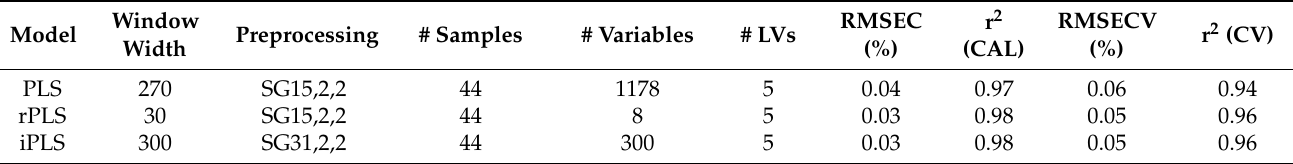
Figure 1. Map of Greece indicating the sample localities. Figure 7. Response surface plot for PLS, rPLS and iPLS models (left, middle and right column). The preprocessing method is plotted against the averaging window width. The color scale corresponds to the RMSECV at the five latent variables (LVs) included. The optimal models, i.e., lowest RMSECV-value, are marked with a X. Table 2. Overview of the optimal NIRS calibration models for FFA. # LVs: number of latent variables, RMSEC: Root Mean Square Error of Calibration, RMSECV: Root Mean Square Error of Cross